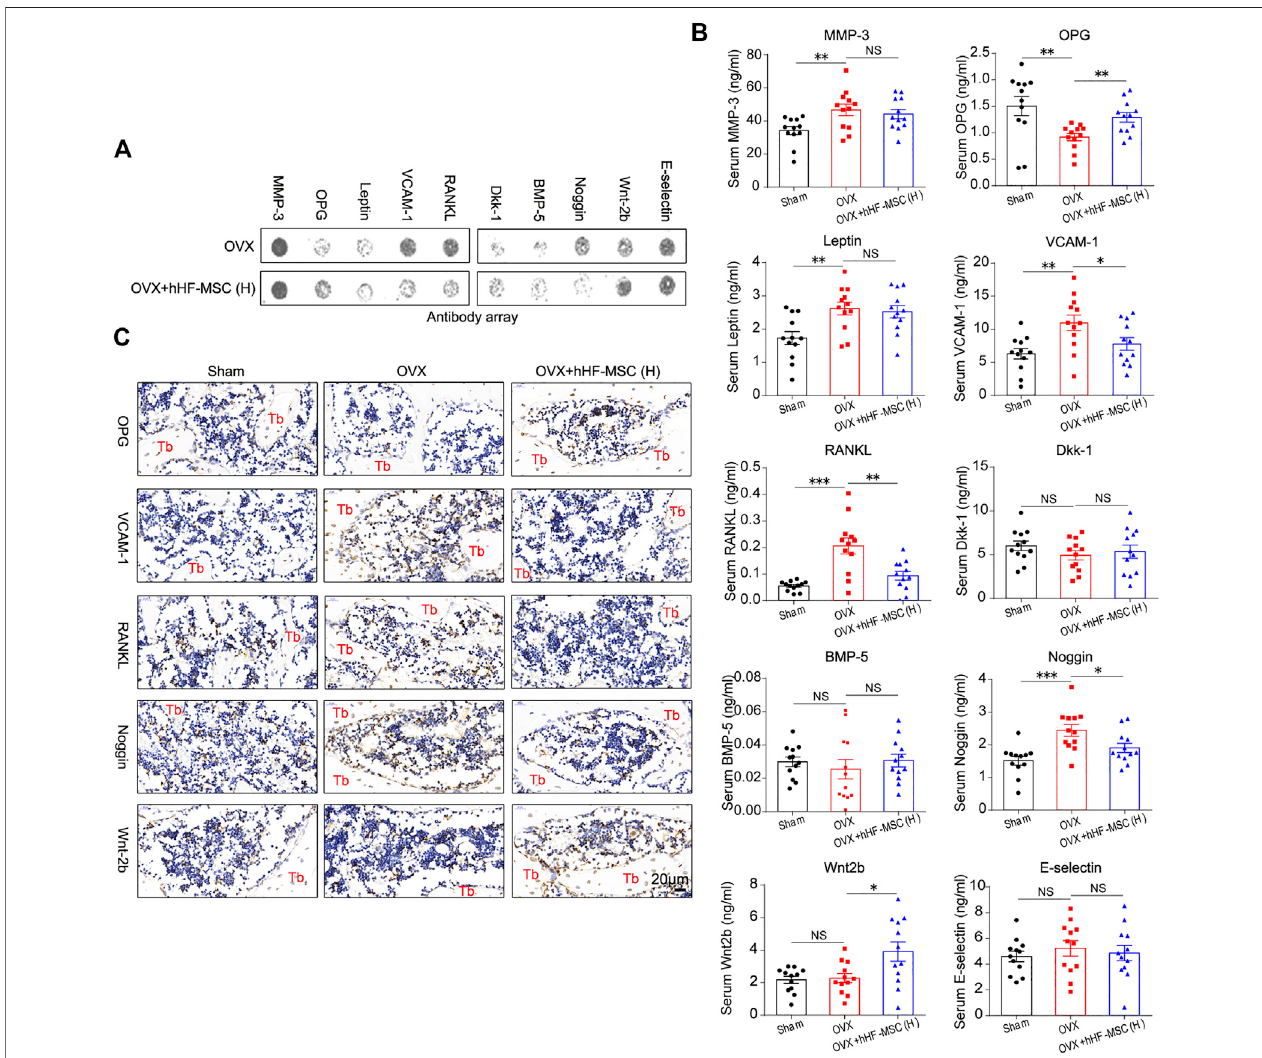
FIGURE 7 | Expression of bone metabolism regulators in serum and bone marrow in OVX-induced osteoporotic mice with intravenous transplantation of hHF- MSCs. (A) Representative image of antibody array against bone metabolism regulators in peripheral blood serum from OVX-induced osteoporotic mice with high-dose hHF-MSCs injection. (B) The levels of bone metabolism regulators in peripheral blood serum from OVX-induced osteoporotic mice with high-dose hHF-MSCs injection determined by antibody array. ( n = 12 for each group). (C) OPG, VCAM-1, RANKL, Noggin, and Wnt2b levels in femur bone marrow of OVX-induced osteoporotic mice in response to high-dose hHF-MSCs injection determined by immunohistochemistry. All the data were obtained from three independent experiments. Data were shown as the means ± s.e.m. *: p < 0.05, **: p < 0.01, ***: p < 0.001, NS: not signi fi cant.